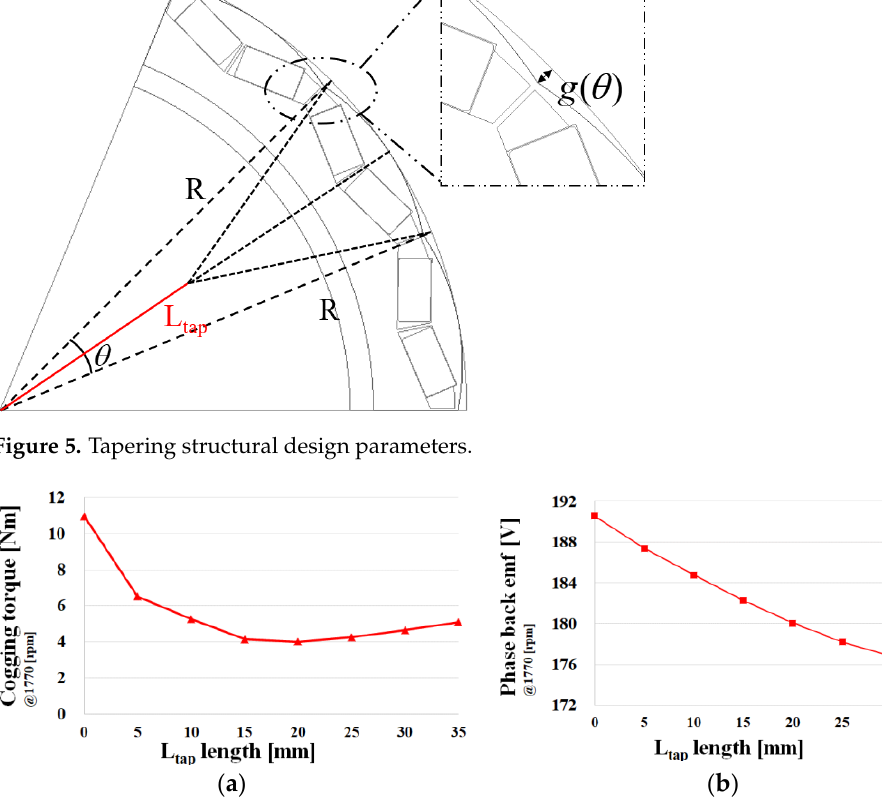
L : (a) cogging torque; (b) back t ap